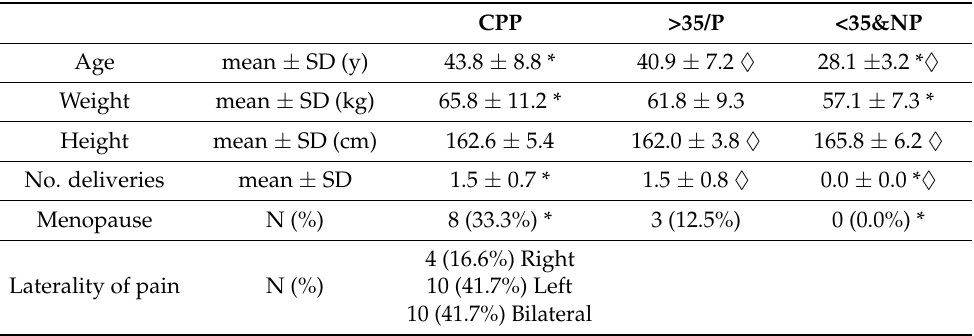
Table 1. Demographic and obstetric characteristics of women from groups Chronic pelvic pain (CPP), over 35 and/or parous (>35/P) and under 35 and nulliparous (<35&NP). Symbols show statistically significant differences between each pair of groups: (*) for CPP vs. <35&NP and ( ♦ ) for >35/P vs.